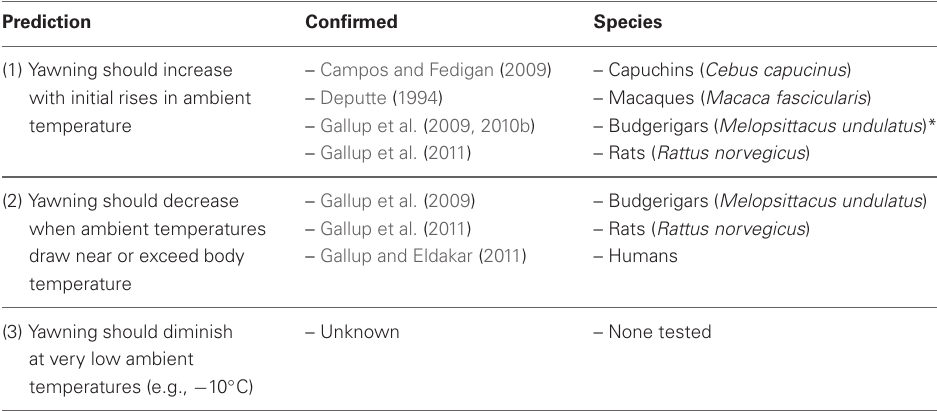
Table 2 | Empirical tests and observations supporting the thermal window hypothesis. Prediction Confirmed